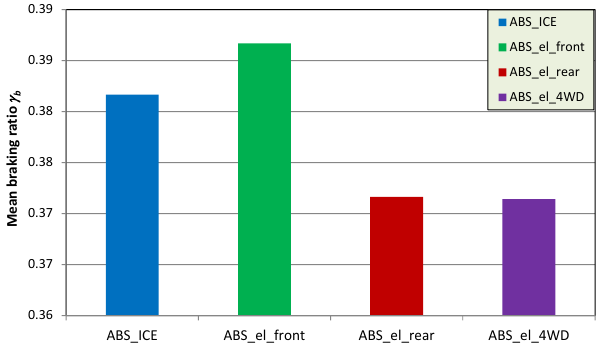
Fig. 11. Distance of stopping the vehicle in braking the vehicle straight ahead on a road with different adhesion coefficient under the wheels of the left and right side [own research]